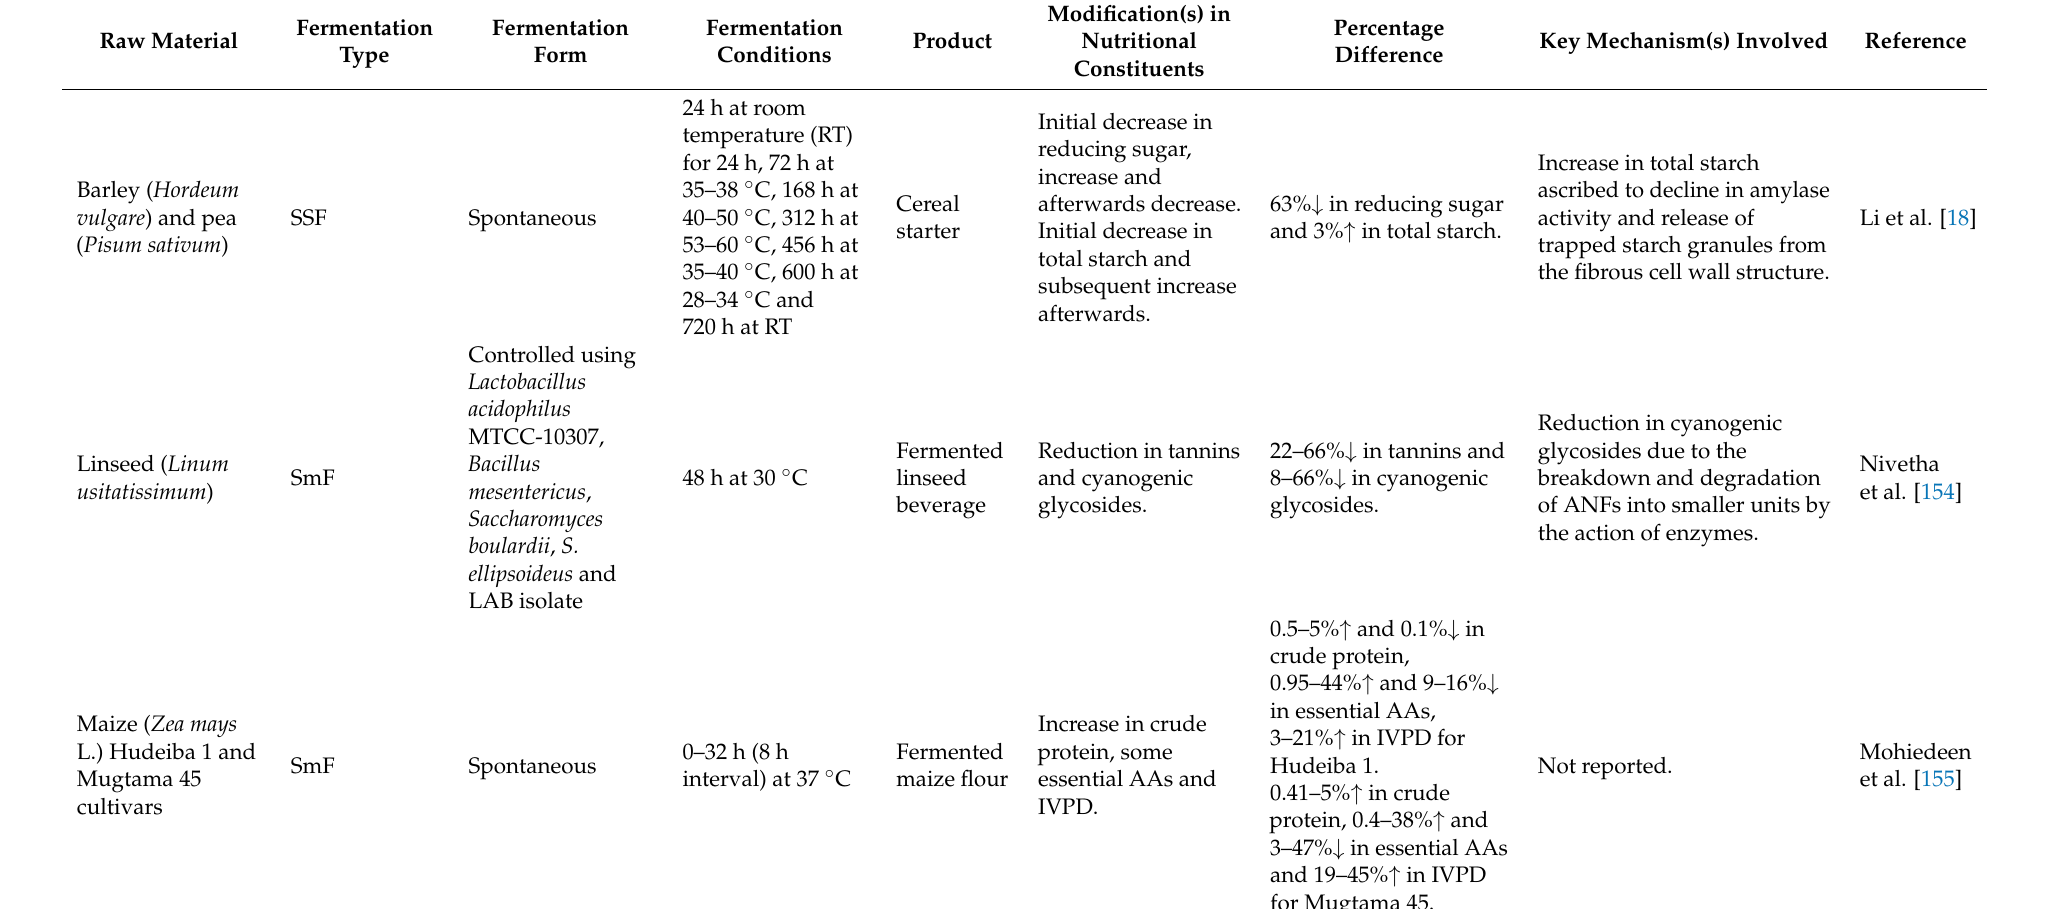
Table 3. Influence of fermentation on the nutritional composition of some cereal-based